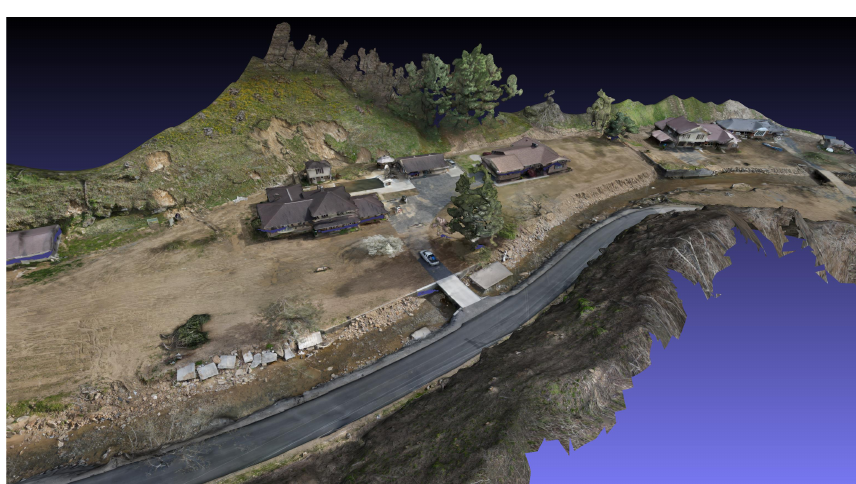
Figure 5. 3D reconstruction of a portion of Guesses Fork Road in Hurley,